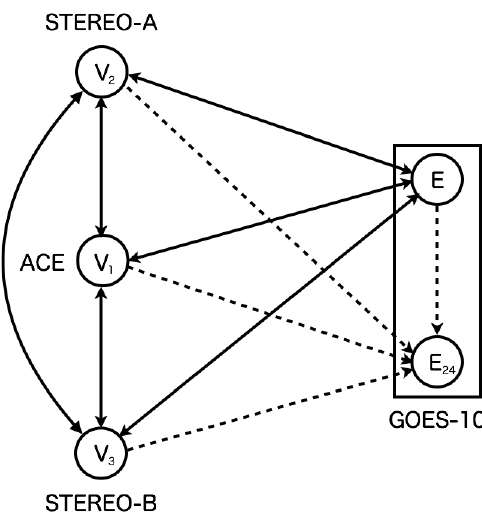
Figure 1. Dynamic relational network for space weather forecast using multiple sensors. The node V i represents the sensor for the solar wind speed. The nodes E and E 24 indicate present high-energy electron flux and flux twenty-four hours ahead. The rectangle represents an internal regions of GOES-10 which equips with couple sensors for observation. Solid line arcs represent a diagnosis flow from a source node to a target node. Dashed line arcs indicate a diagnosis flow involving a prediction from a source node to a target